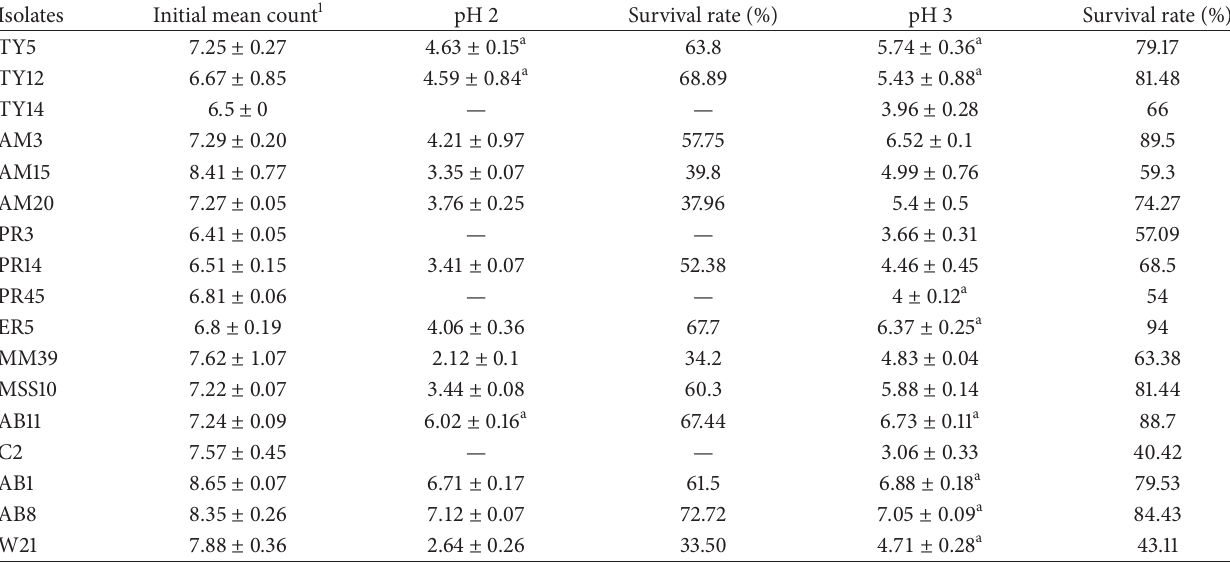
Table 2: Survivability of LAB isolates at acidic condition.